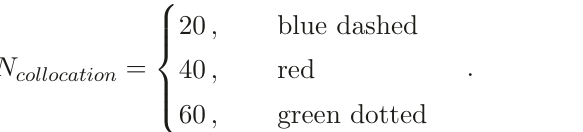
Figure 15 . Evolution of expectation values of in the unstable regime, i.e., with resolutions of the numerical